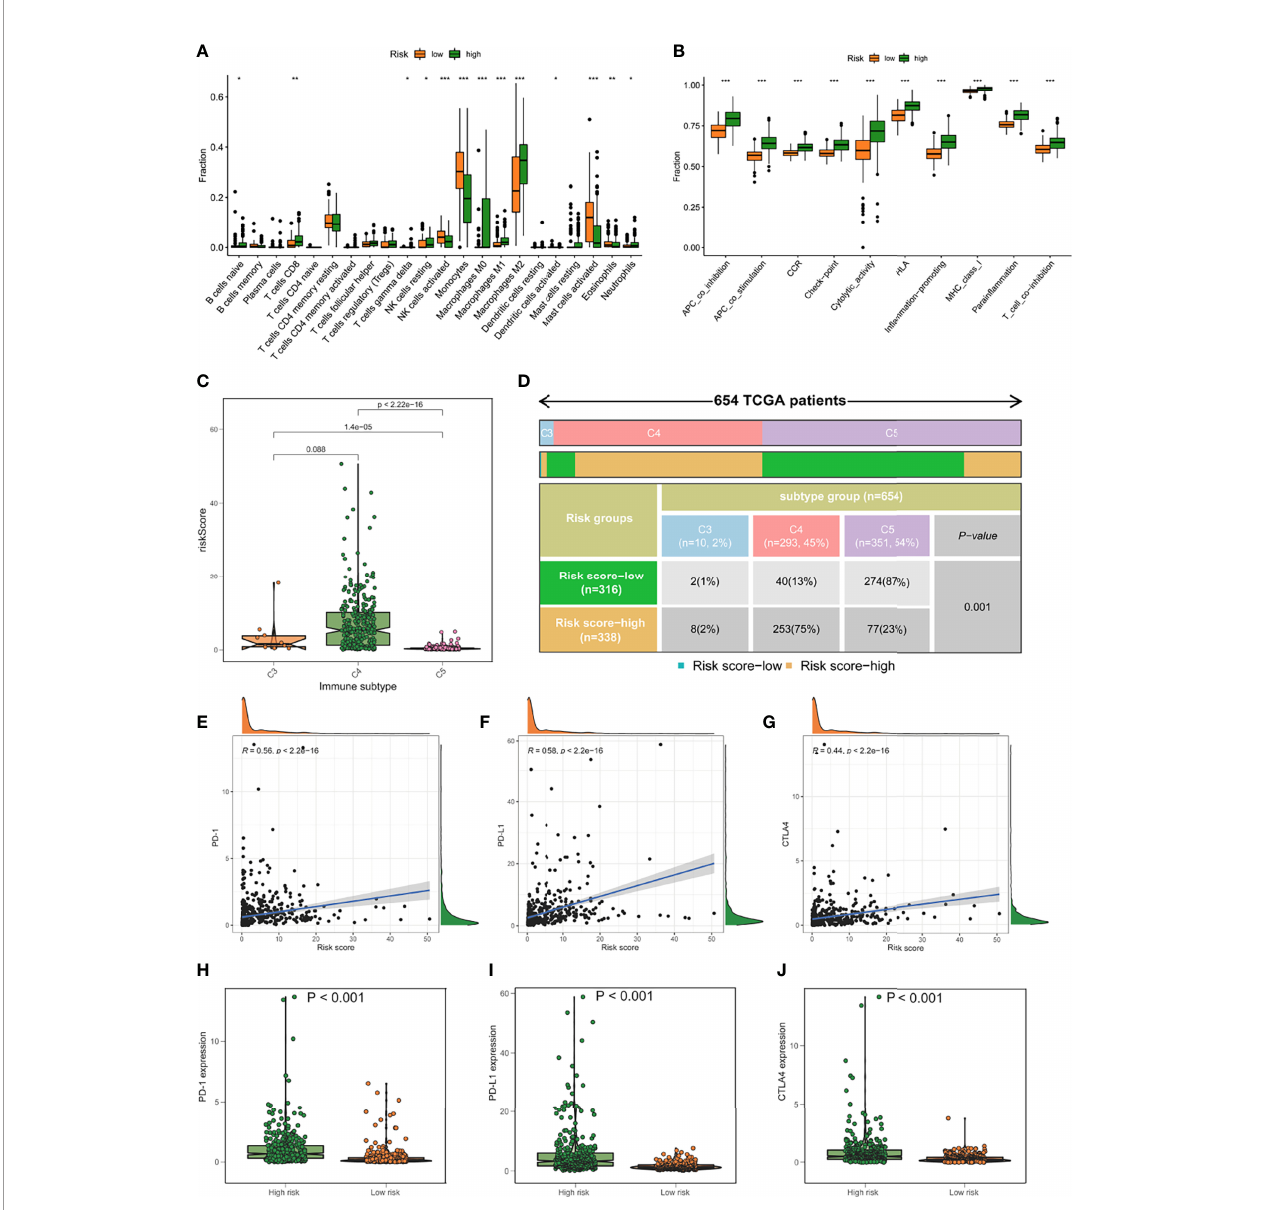
FIGURE 8 | Model of fatty acid metabolism in immunotherapy. (A) The difference in immune in fi ltration between high-risk and low-risk scores. (B) The difference between subjects with a high score and those with a poor rating in terms of the known function related to immune modulation. (C, D) The distribution of immunological subtypes (C3, C4, and C5) across risk groupings are shown in a heatmap and table. (E – G) Immune checkpoint transcriptional activation and hazard score, PD-L1 (E) , PD1 (F) , and CTLA3 correlation analysis (G) . (H – J) The disparities between the low-risk and high-risk groups in terms of identi fi ed Immune checkpoint genes. *P<0.05, **P<0.01,